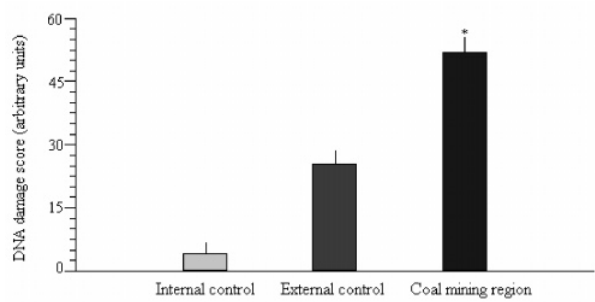
Figure 3 - Mean DNA damage score ( – SD) (arbitrary units) for rodents from Pelotas (external control) and Candiota (coal mining region) and for human blood (internal control). *P<0.05 compared to Pelotas. Student’s two-tailed t -test in both cases.